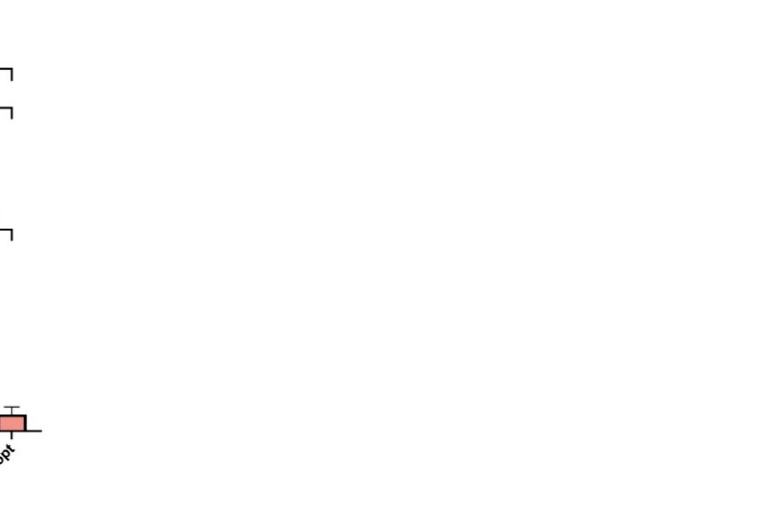
Figure 6. In vivo IFN- γ responses following C57BL/6 mice vaccinations. Comparing serum IFN- γ levels in each of vaccine constructs (S.opt.FL, S1.opt, and S.opt.FL+S1.opt) 2 weeks following second immunization in each vaccine construct using pooled mice sera from each group. Endpoint concentration was determined by titers expressed (mean ± SD). Data were analyzed with one-way ANOVA with Tukey’s multiple comparison test. The asterisks refer to the level of significance: *** p < 0.0002; ns: no significant difference.